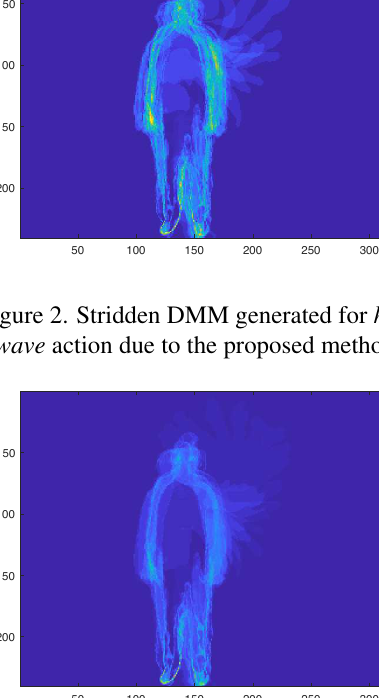
Figure 3. DMM generated for high wave action due to an existing method (Chen et al.,